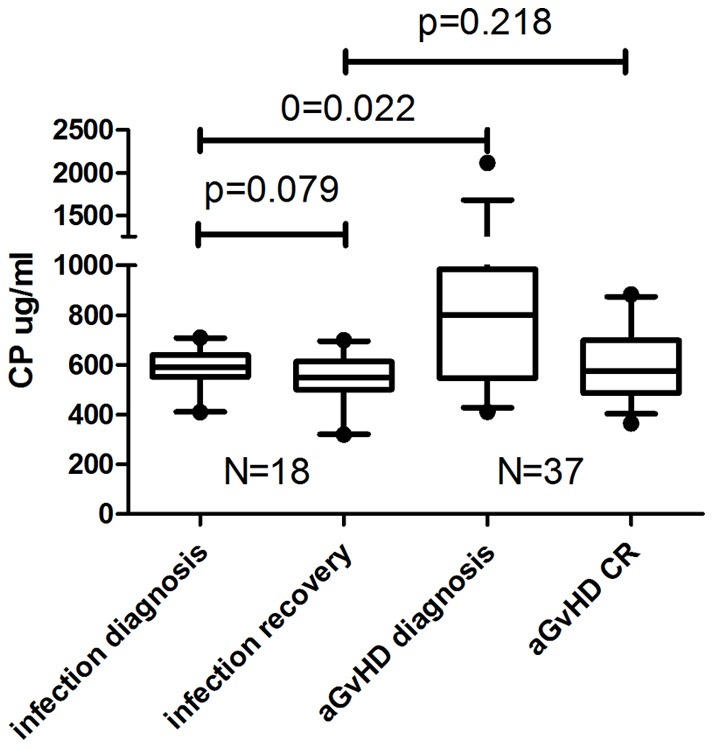
Comparison of ceruloplasmin levels in infection and aGvHD.Infection+aGvHD- (n = 18; systemic n = 11; symptomatic n = 7) and aGvHD+infection- (n = 37; systemic n = 16; symptomatic n = 21) were compared at diagnosis of complications as well as recovery.